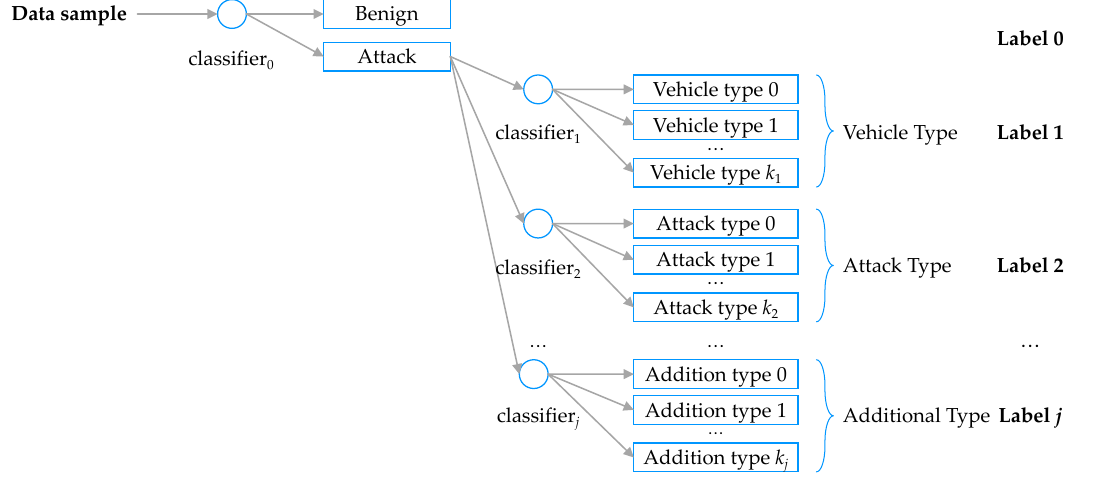
Figure 6. MLHC target